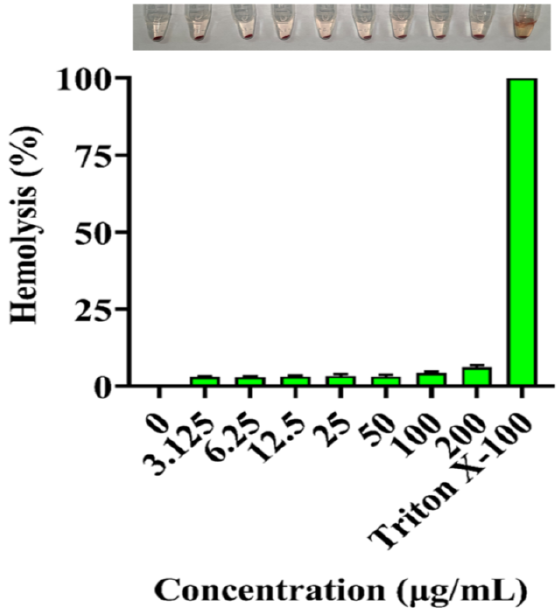
Figure 16. Hemolysis analysis of MIL-101(Fe)@Ag (Ag 0.0127 wt%). Physiological saline and 0.1% Triton X-100 were used as negative and positive controls, respectively.